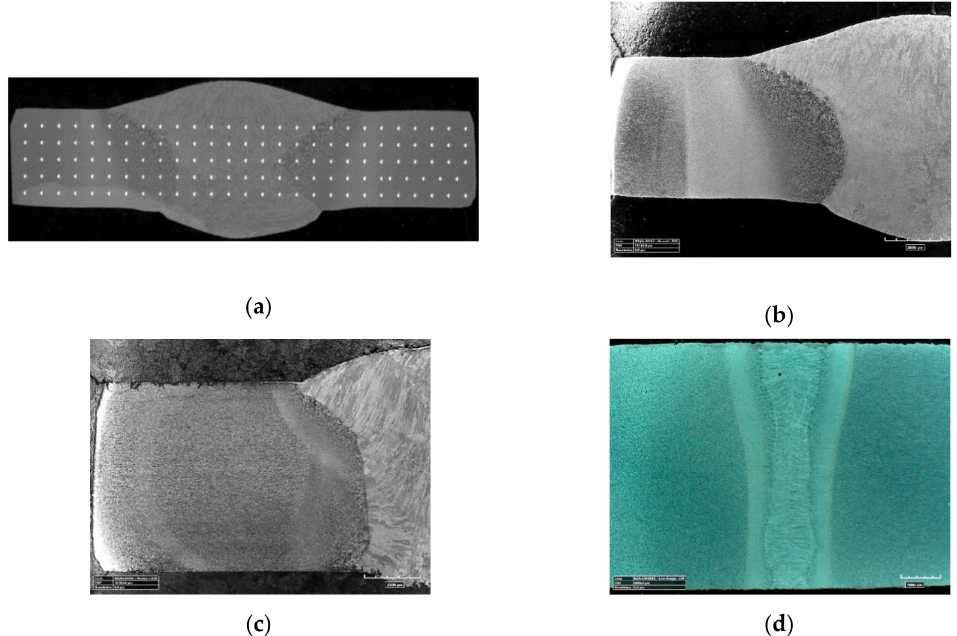
Figure 2. Views of cross-section of the welded joints with di ff erent level of Linear Welding Energy (LWE): ( a ) With measurement hardness points; ( b ) for Q 1; ( c ) for Q 3; ( d ) for Q 5.